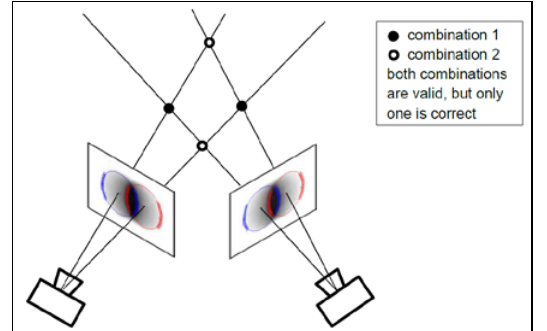
Control points Monitoring